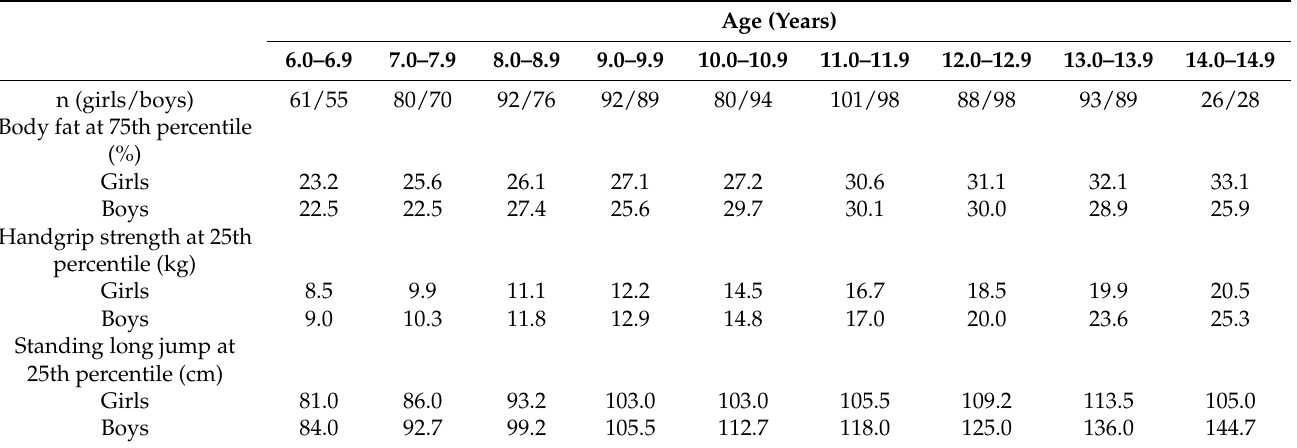
Table 1. Cutoff values to determine the risk of elevated body fat, low handgrip strength, and low standing long jump by sex and